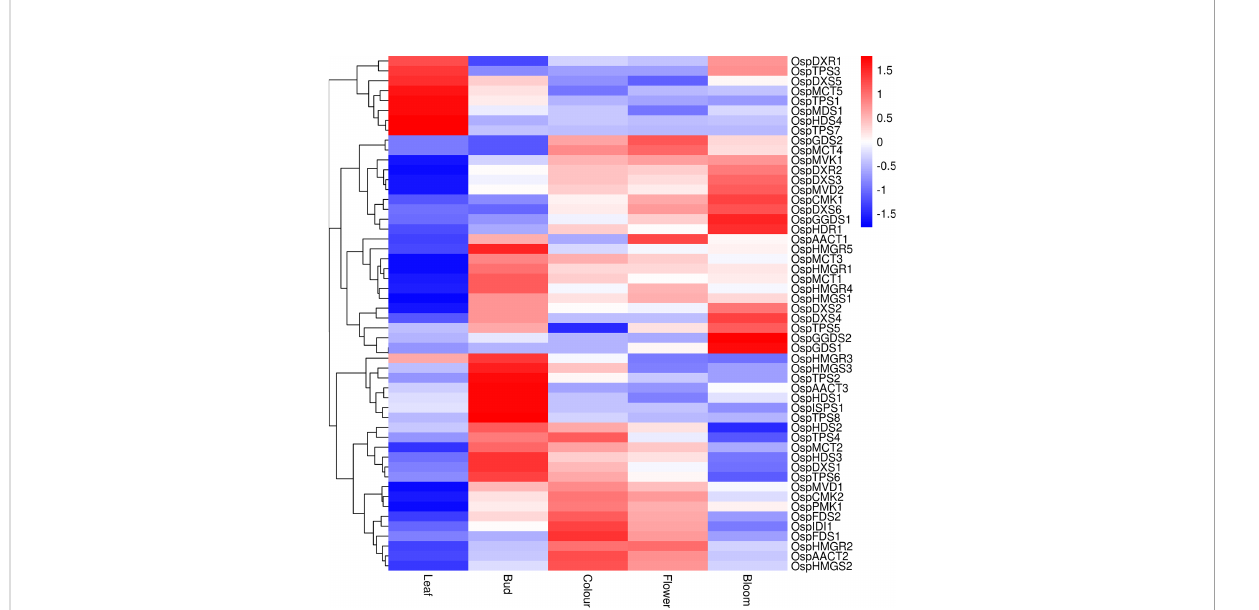
FIGURE 6 Heat map showing expression patterns of genes related to terpenoids in ‘ Taihang Mingzhu ’ leaf and in fl orescences at different stages of